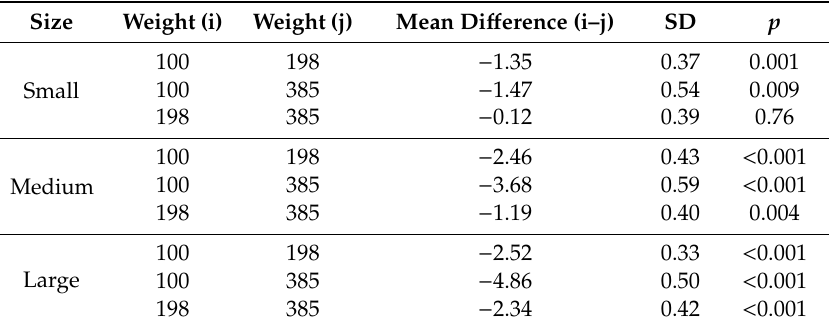
Table 7. Preference comparison of the three cookie box